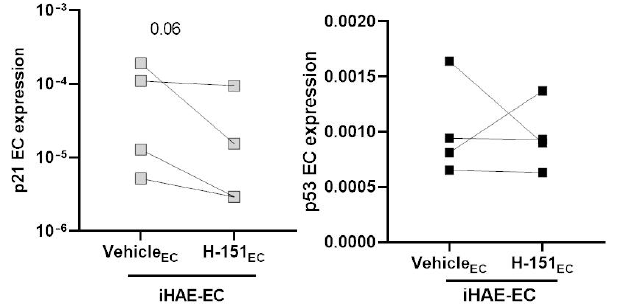
Figure 5. p21 and p53 ECs gene expression after H151 treatment in iHAE-EC co-culture. Gene expression analysis of p21 ( left panel) and p53 ( right panel) in ECs during co-culture with SARS-CoV-2 infected HAE (iHAE-EC) in the presence of H-151 (or vehicle) as indicated (n = 4). Values are presented as mean ± SEM. The Wilcoxon matched-pairs signed rank test was used for group comparison. p -value is reported in the graph.